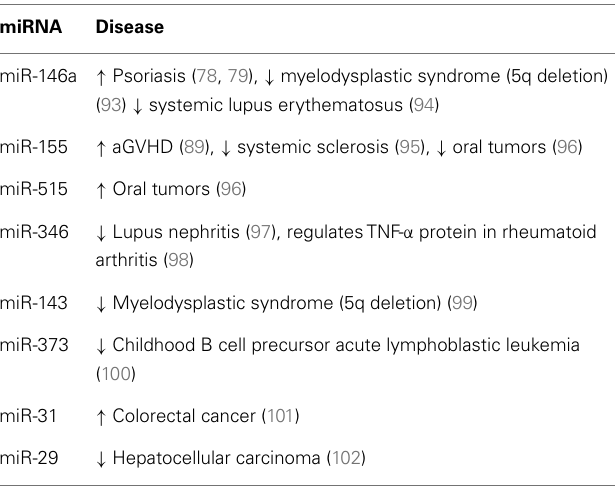
Table 3 | miRNAs identified via Ingenuity Pathway Knowledge base to be implicated in the GVHD signaling